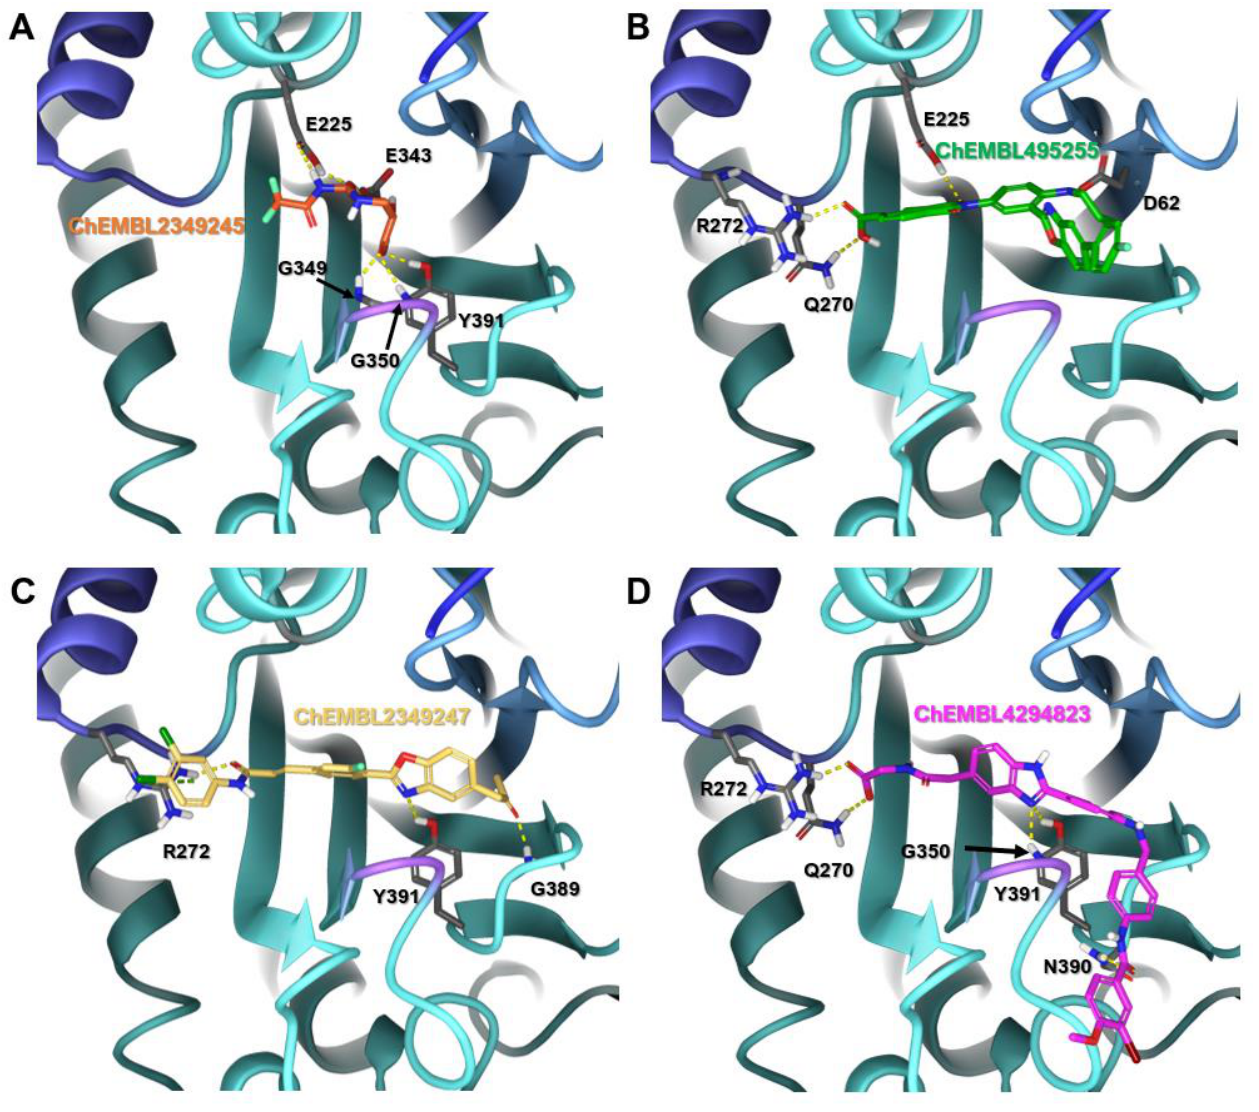
Figure 3. HPSE in complex with the selected reference hit compounds: ( A ) ChEMBL2349245 (orange); ( B ) ChEMBL495255 (green); ( C ) ChEMBL2349247 (ochre); ( D ) ChEMBL4294823 (pink tubes). H-bonds are shown in yellow dashed lines and pi-cation interactions in green. Molecules are shown in stick representation.